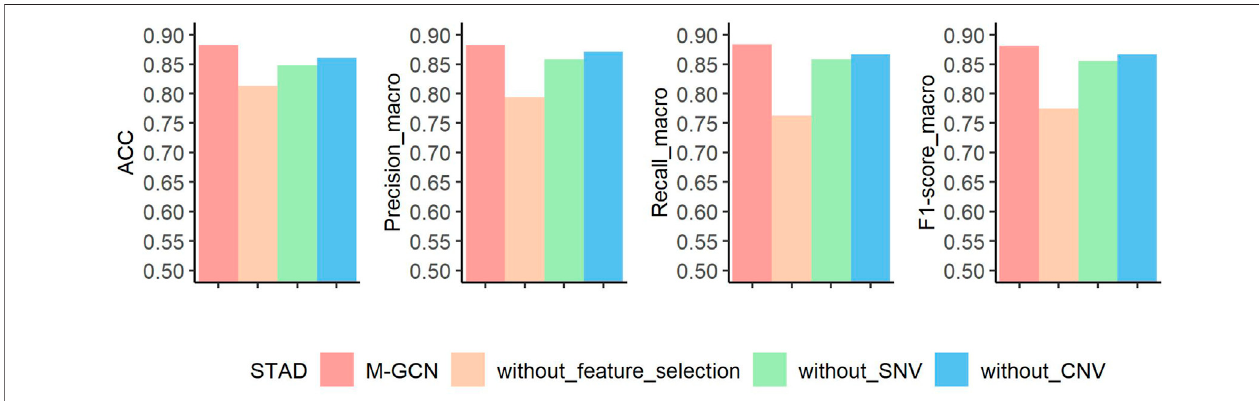
FIGURE 5 | Results of ablation experiment of M-GCN in STAD. Pink bar represents the fi nal performance of M-GCN, orange bar represents the performance of ( Table 3 ), M-GCN has a 100% predictive power for EBV stomach cancer, and a 90% probability of correctly predicting the MSI type. However, GS is relatively hard to predict, especially not easily distinguishable from CIN.